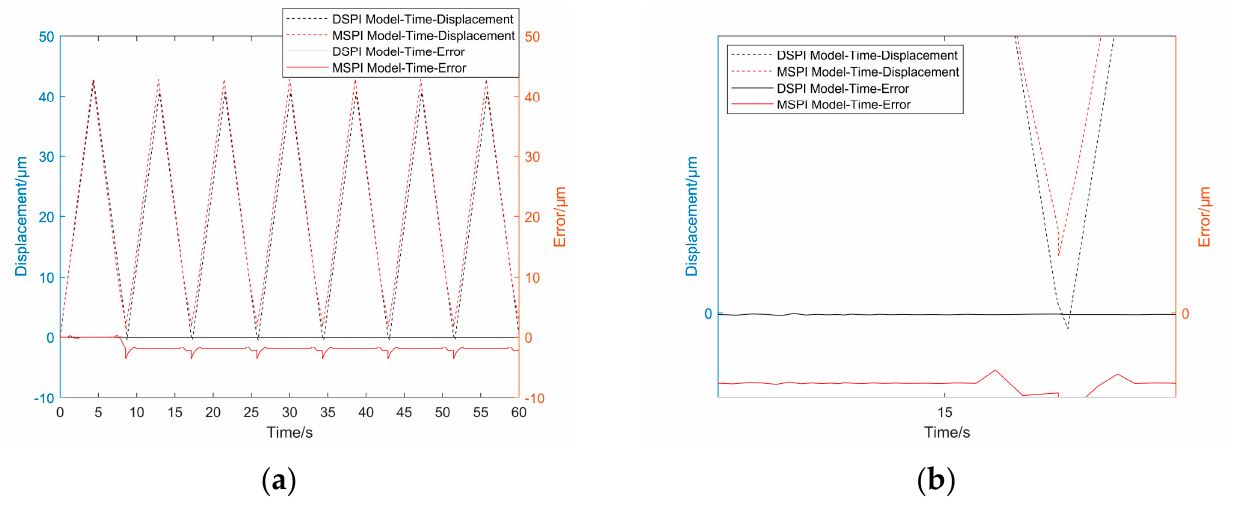
Figure 25. Time–displacement–error curves of DSPI Model and MSPI Model: ( a ) overall diagram; ( b ) local enlargement.